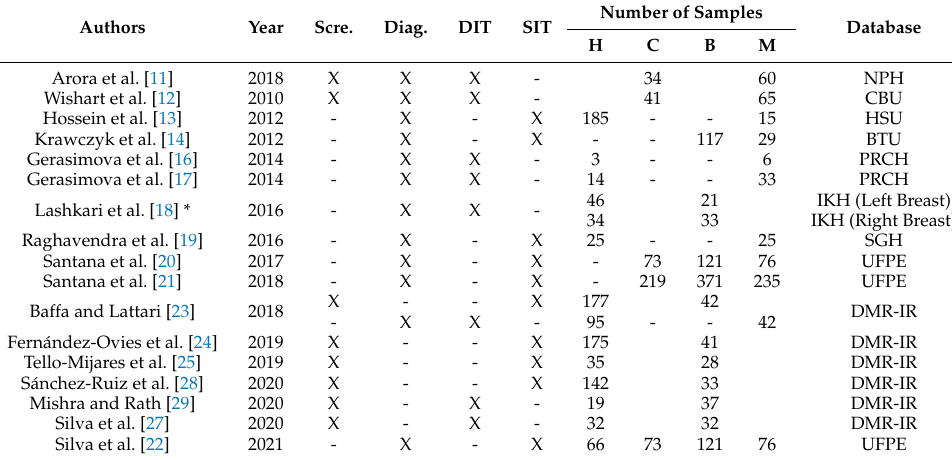
Table 1. Comparison of related work using thermographic